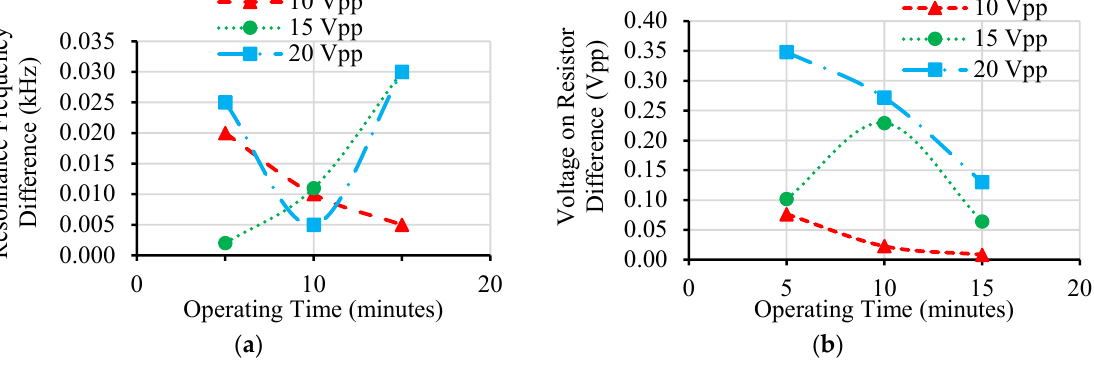
Figure 12. Operating time and input voltage effects over; ( a ) The variation of the resonance frequency; and ( b ) The variation of the resistor voltage for T1 transducer.